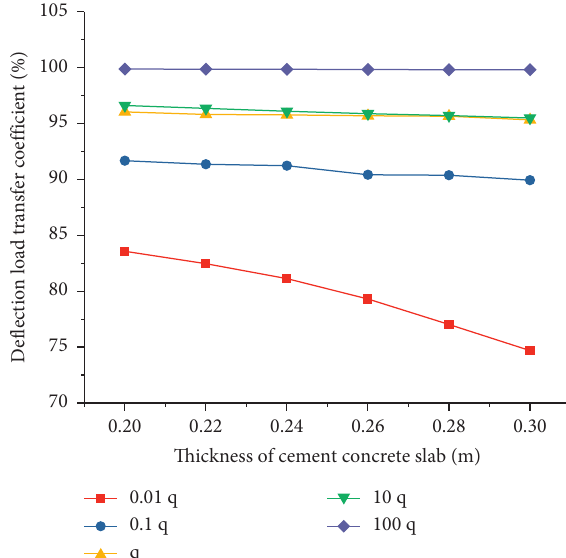
Figure 10: Variation of deflection load transfer coefficient with respect to the thickness of cement concrete slab under different values of spring stiffness.